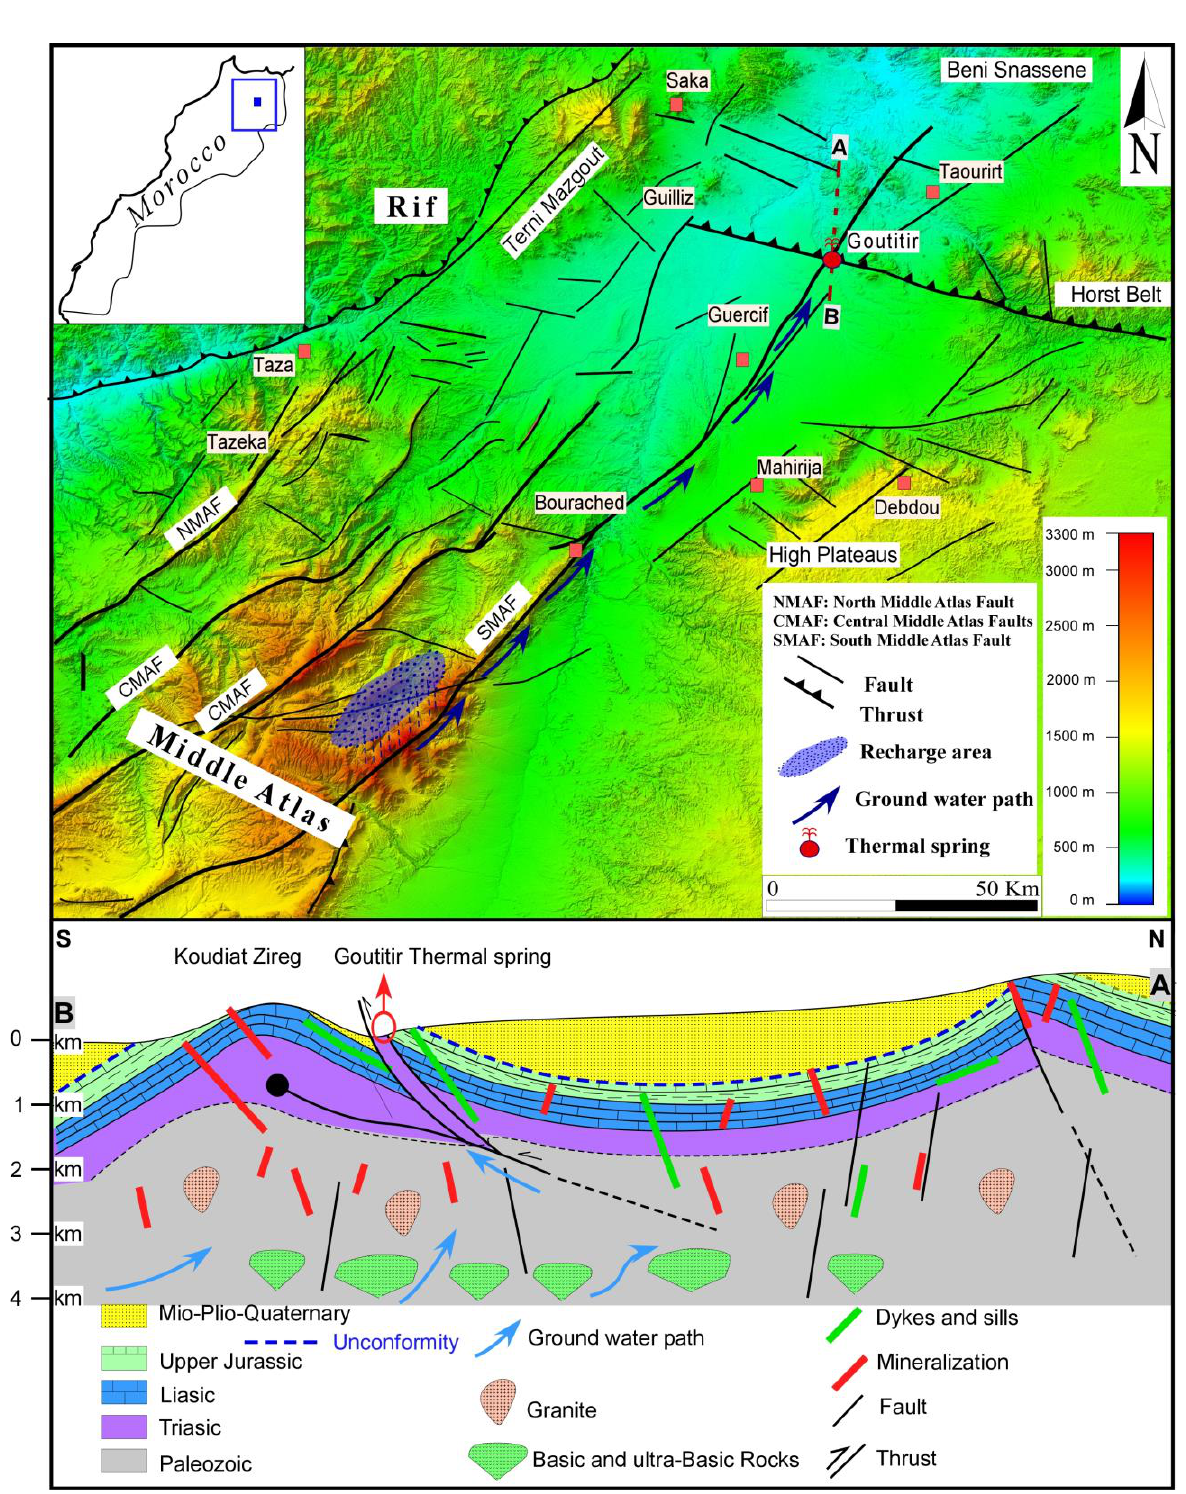
Figure 12. Schematic structural map of the north of Morocco, showing the zones of probable recharge (blue zones) and paths of the groundwater flow (blue arrows) of the studied thermomineral water of the Goutitir, as well as a schematic cross section (A-B) showing the lithological background along with the recharge path of the spring water.